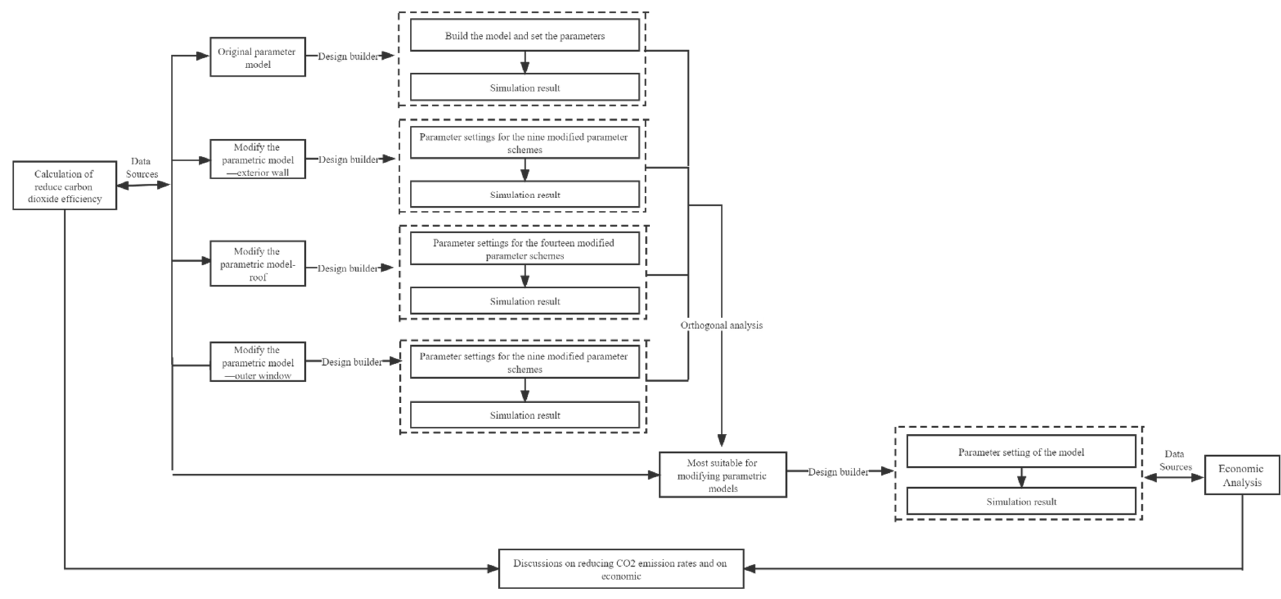
Figure 2. Study flow